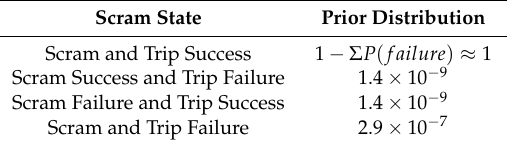
Table A2. Prior distribution for SCRAM state.